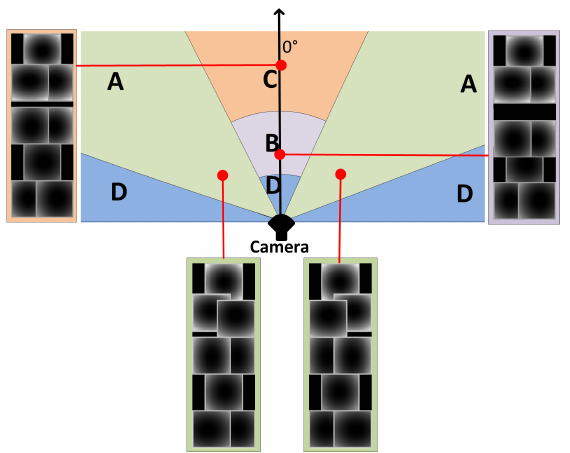
Figure 12. Illustration of adapted deformable part model to fisheye